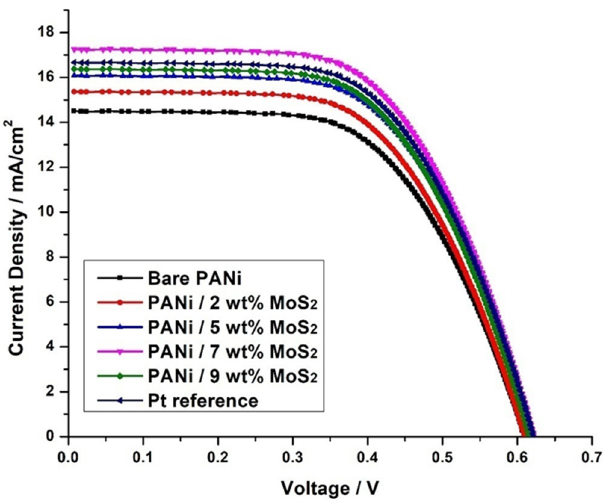
Table 1. A detailed summary of I-V parameters. Sr. No. Figure 3. Current-voltage curves of specimens under